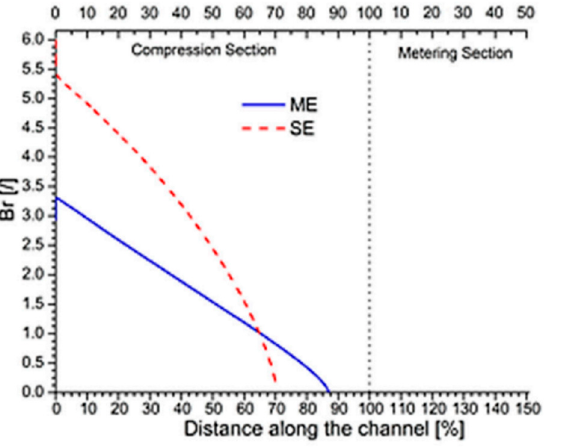
Figure 8. Brinkman number (Br) along screw channel direction for both the standard extruder used in the IM process (SE) and the mini-extruder (ME) used in the pellet extrusion-based process—reprinted from [7].